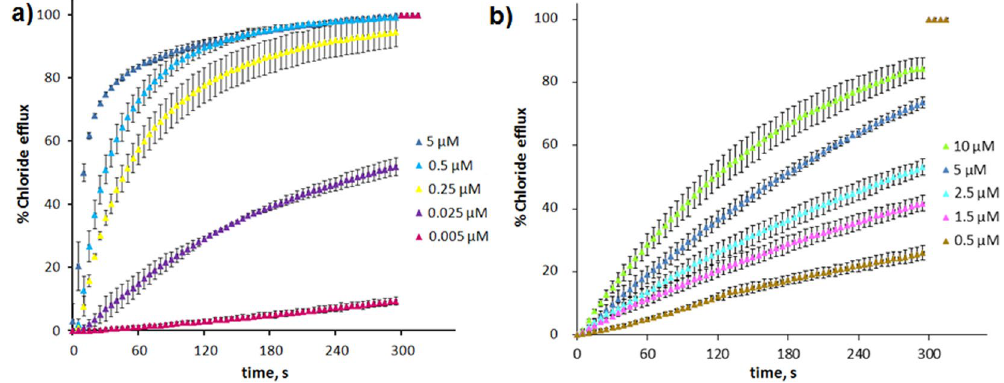
Figure 3. Chloride efflux upon addition of 1a .HCl. ( a ) Time course of the normalized chloride concentration upon the application of the anion carrier at different concentrations, from 0.005 µ M to 5 μ M, as indicated in the figure. The LUV contained 489 mM NaCl and 5 mM phosphate buffer, pH 7.2, and were suspended in 489 mM NaNO figure. The LUV contained 451 mM NaCl and 20 mM phosphate buffer, pH 7.2, and were suspended in 150 mM